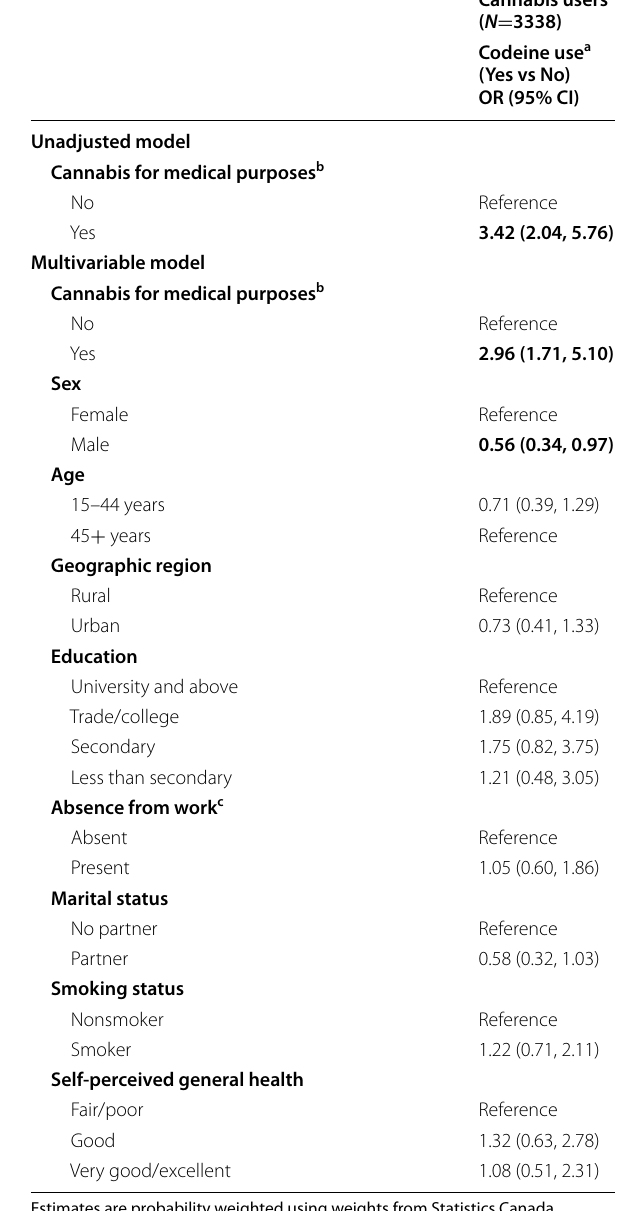
Abbreviations: OR odds ratio, CI confidence interval